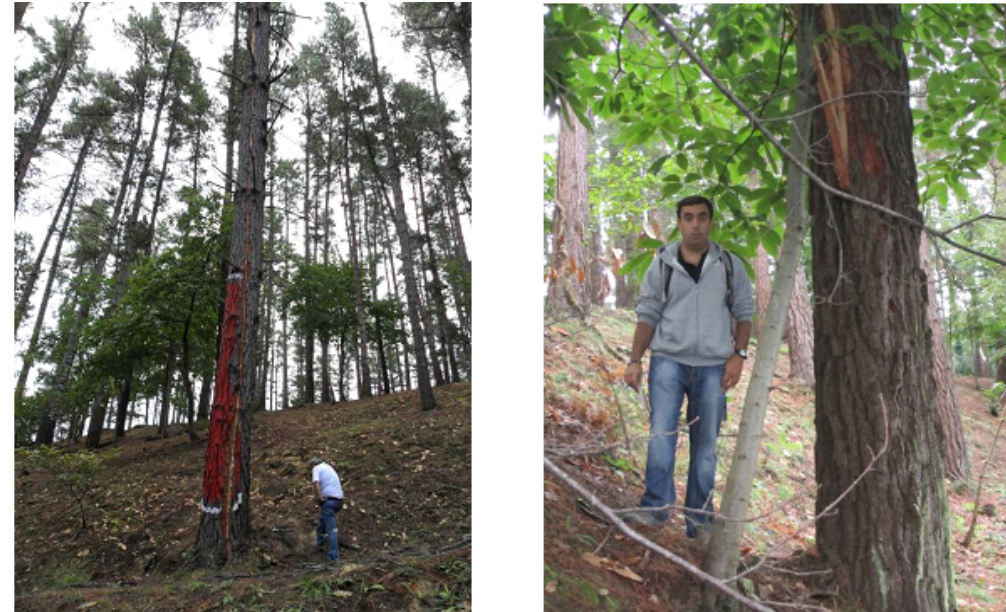
Fig. 4. Wound over the Pinus radiata (left) and over the dead trunk (right).